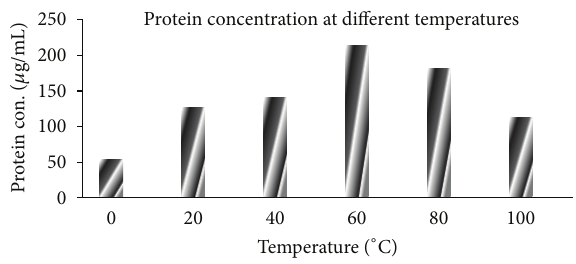
Figure 6: Effect of temperature on extracellular protein secretion by fungal biomass: biomass kept at 60 ∘ C shows maximum protein secretion.